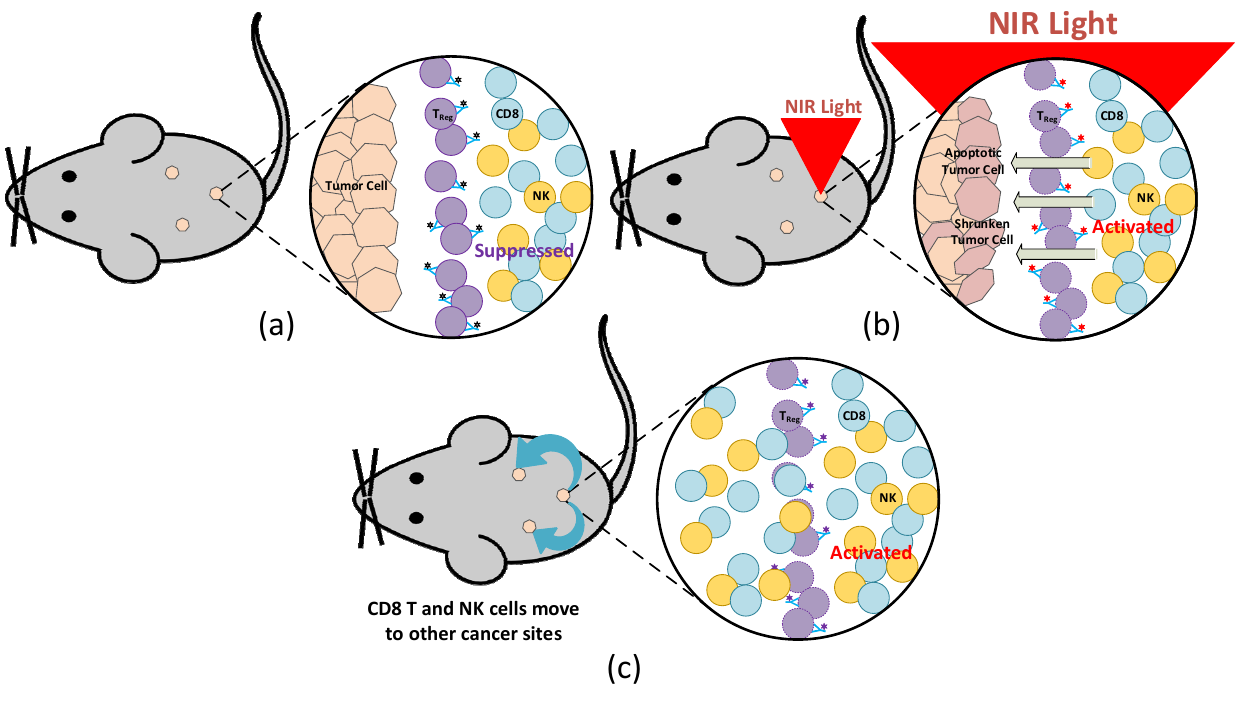
Figure 3. Mice model illustration with NIR-PIT: ( a ) before and ( b ) after NIR light irradiation, as well as ( c ) when CD8 + T and NK cells migrate to other cancer sites. as ( c ) when CD8 + T and NK cells migrate to other cancer